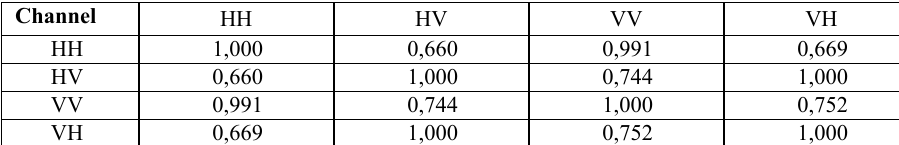
Table 2. The correlation matrix for the scene with the